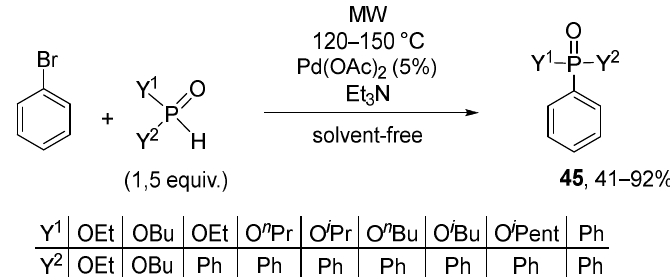
Table 15. MW-assisted Hirao reaction of bromoarenes and diethyl phosphite applying Pd(OAc) 2 as the catalyst